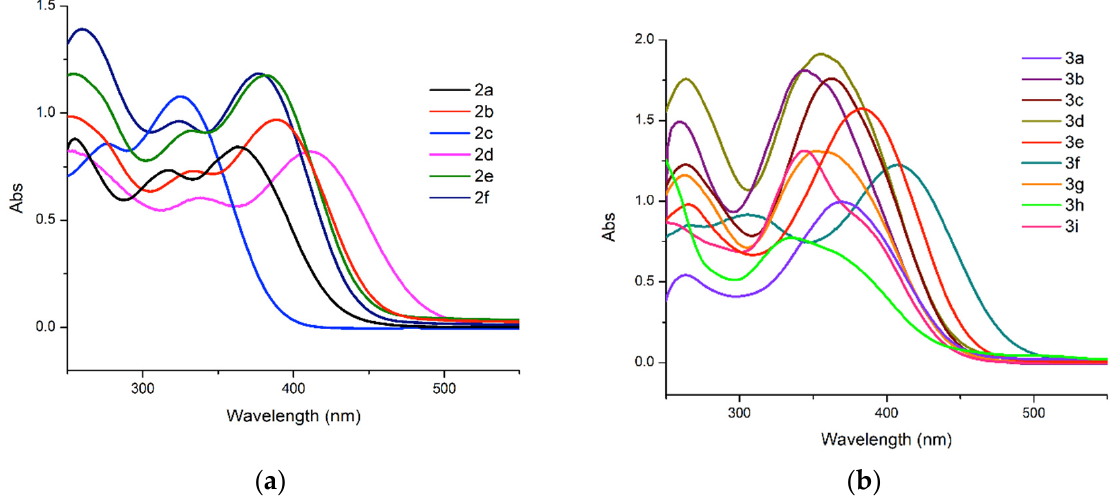
Figure 1. Absorption spectra of the monoarylated DPDTEs ( 2a – f ) ( a ) and diarylated DPDTEs ( 3a – i ) ( b ) at 298 K in CHCl 3 solution (C = 10 − 5 M). Table 2. Photophysical data of the arylated DPDTE ( 2a – f , 3a–i